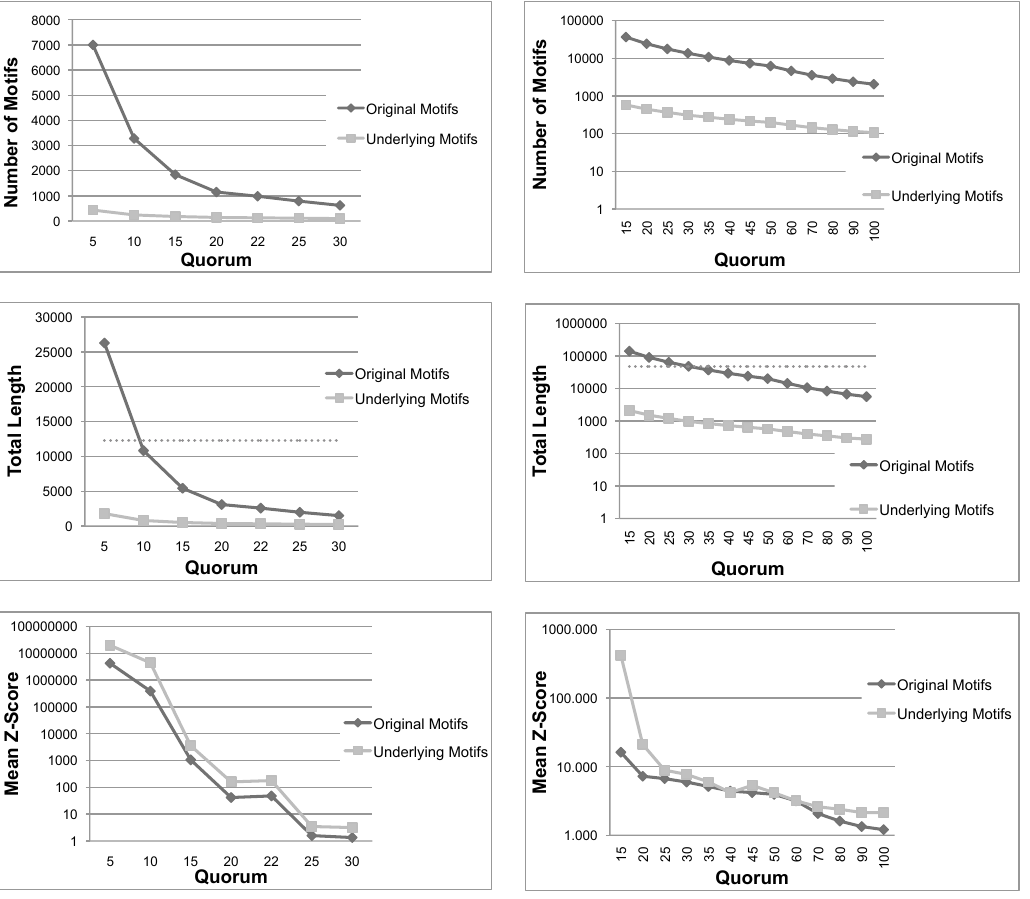
Figure 1. Total number, sum of lengths and mean z -score of the patterns extracted using Varun and their corresponding underlying patterns, for the two protein families, Ni and F a . The dashed line in the total length diagrams indicates the total size of each family. Note that in ( a ) Mean Z -Score and ( b ) All diagrams, the ordinate is plotted on a logarithmic scale. ( a ) Nickel-Dependent hydrogenases ( Ni ); ( b ) Coagulation factors 5/8 type C domain ( F a